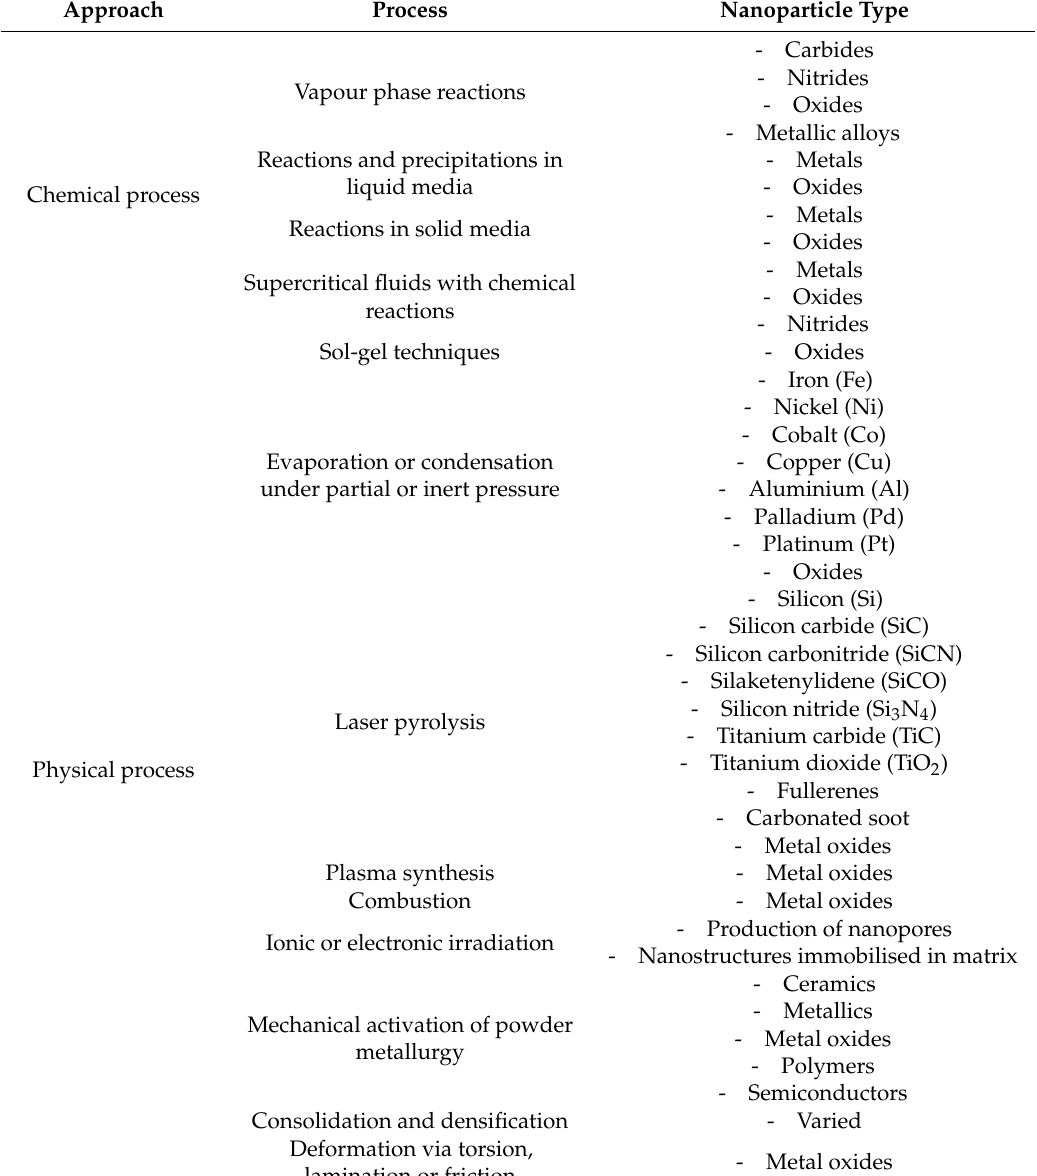
Table 2. Process of engineered particle synthesis and particle type. Table produced utilising data travail (IRSST)